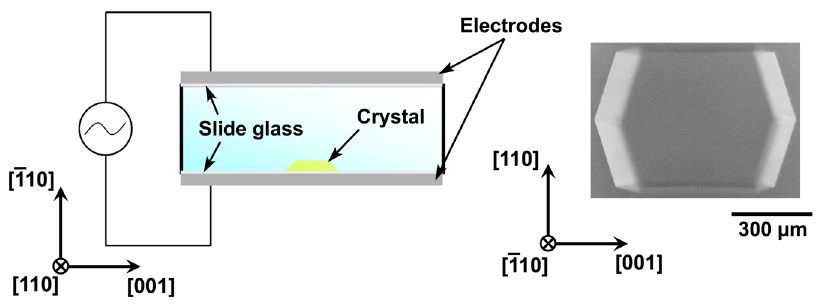
Figure 1. Schematic illustration of the experimental arrangement with electrodes on both sides of the growth cell.